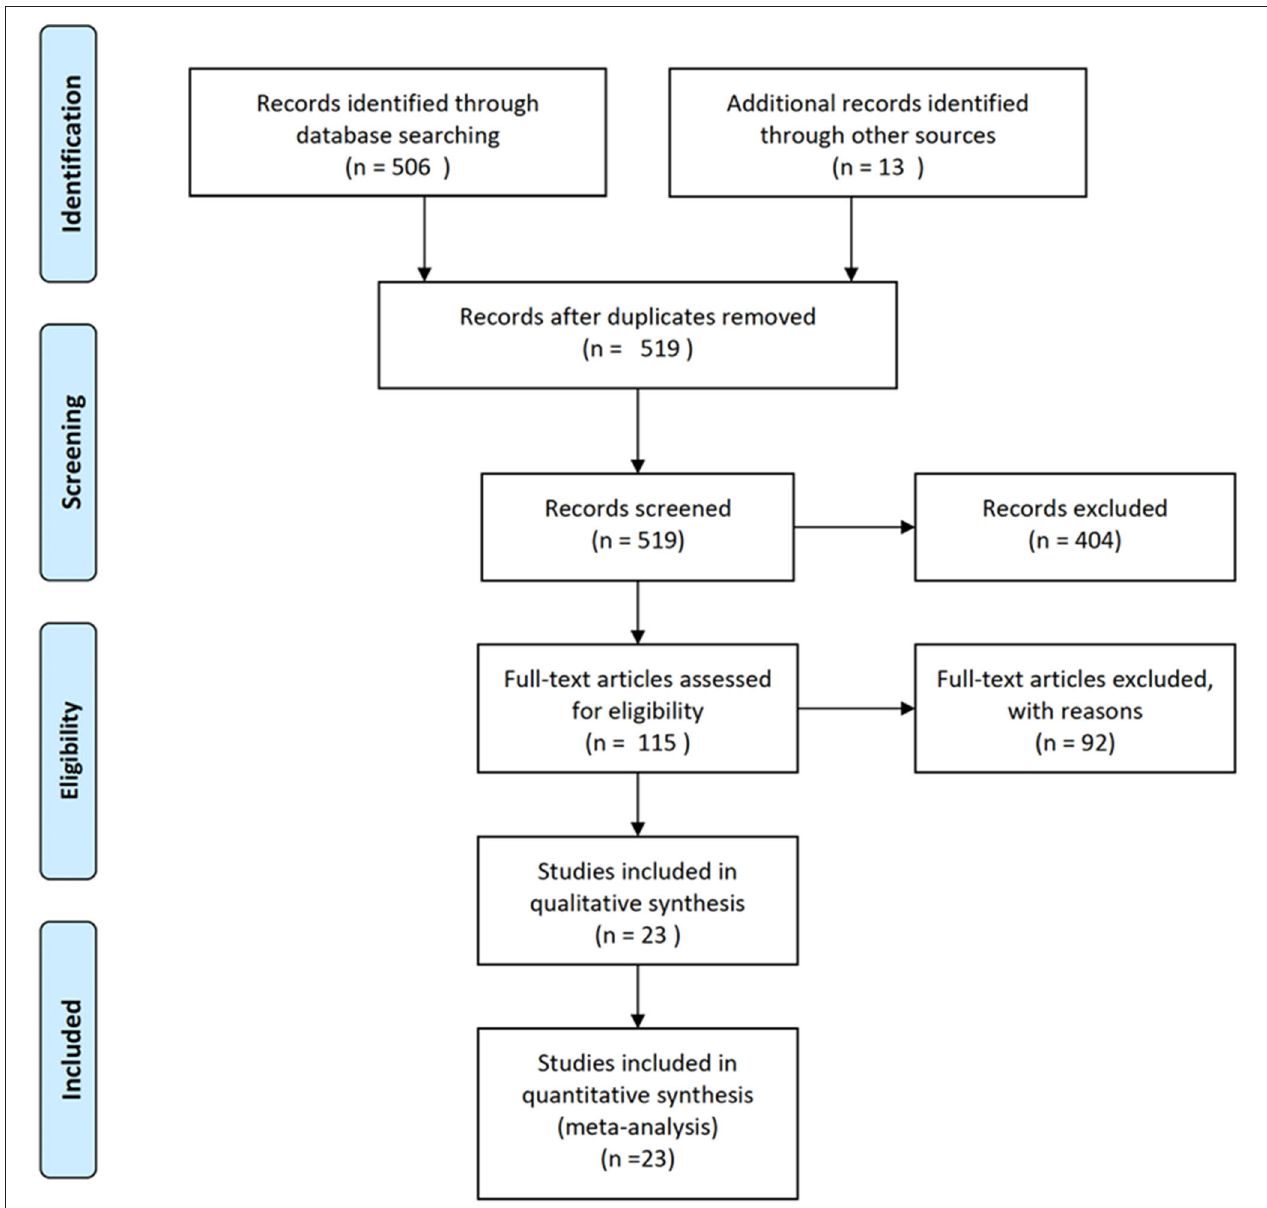
FIGURE 1 | PRISMA flow diagram of the studies retrieved for the